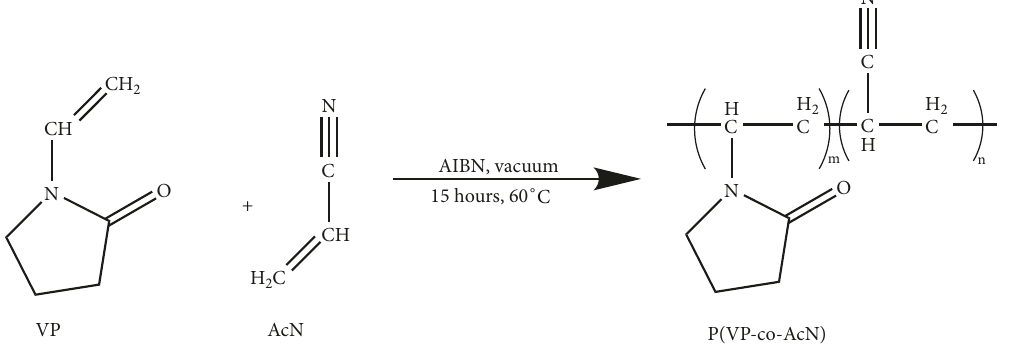
Figure 1: Schematic representation for the synthesis of the copolymer, P(VP-co-AcN).